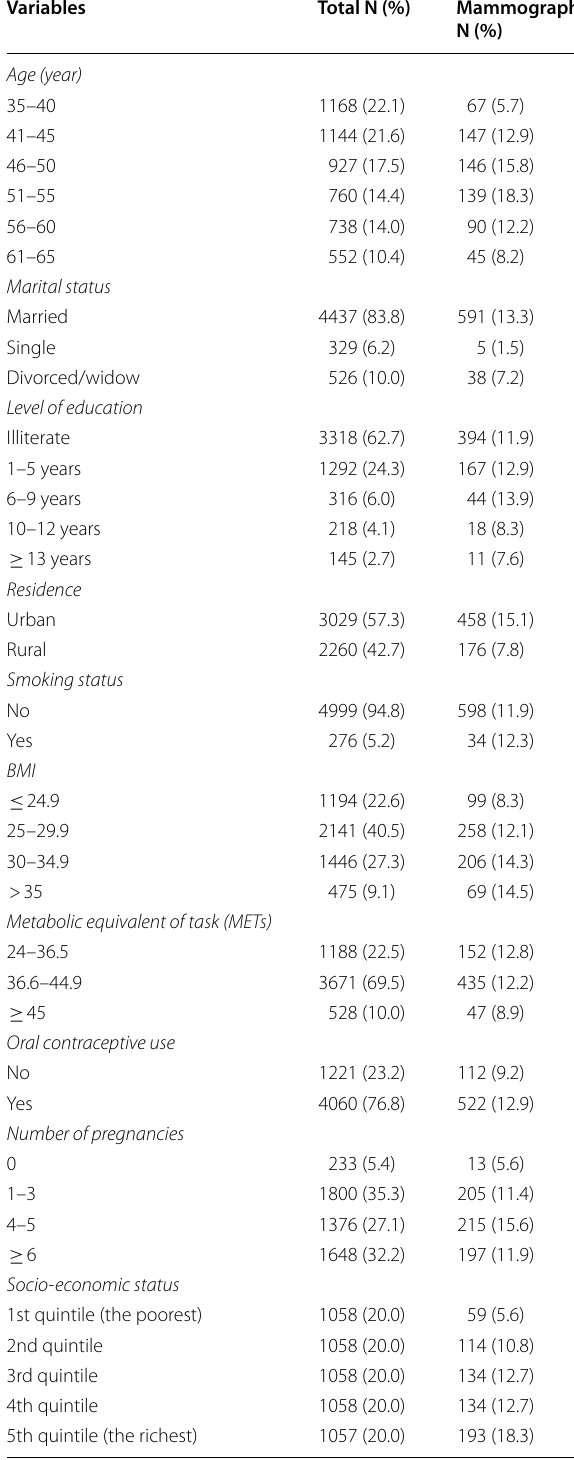
Table 1 Demographic characteristics of the